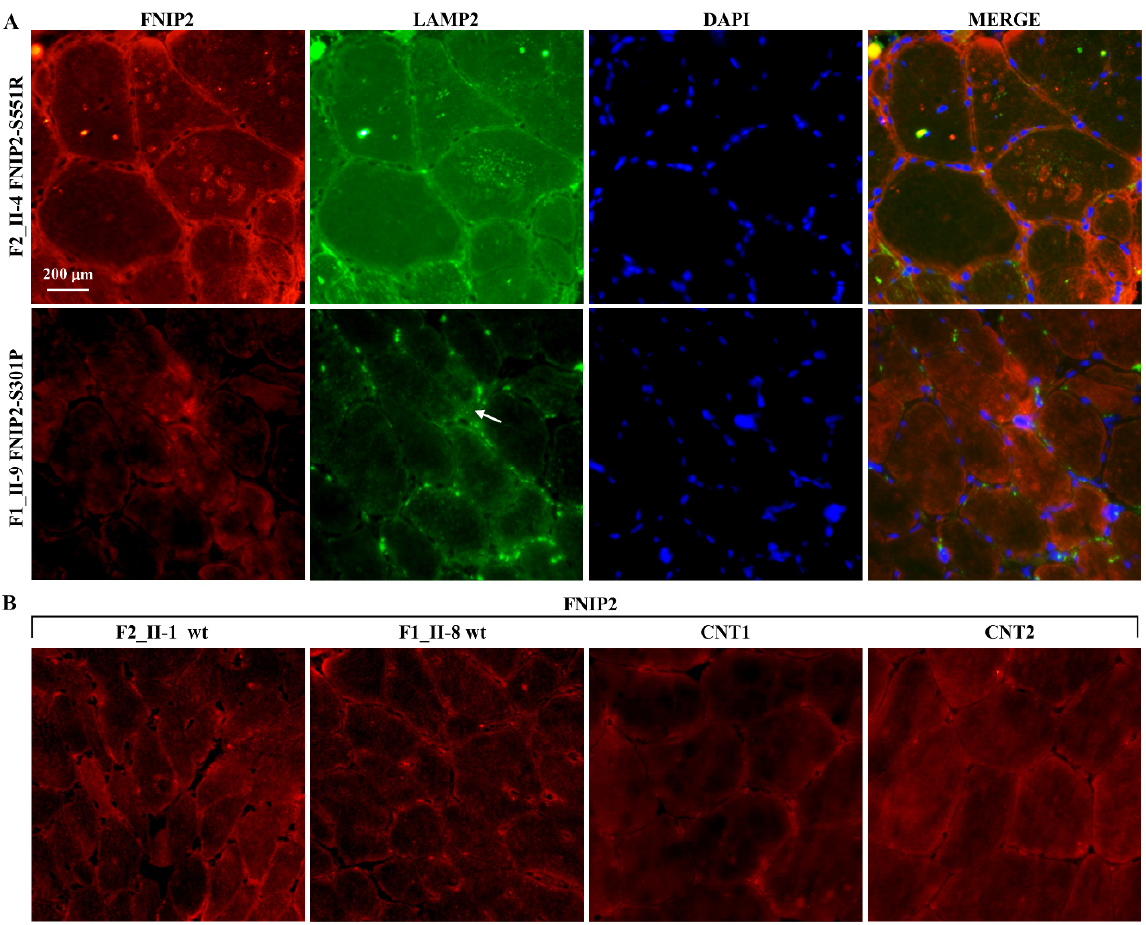
Figure 9. FNIP2 and LAMP2 immuno-localization on skeletal muscle biopsies. ( A ) FNIP2/CY3 expression was continuous and intense at the level of the sarcolemma membranes, and in the sarcoplasmic vacuoles and microvacuoles in FNIP2 [p.S551R] mutated biopsies, while more or less extended irregularly shaped spots of positive signals appeared at the edge in some fibres in (p.S301P) mutated biopsies. The LAMP2/FITC reaction was quite superimposable to that of FNIP2 in these biopsies. ( B ) A faint and diffuse FNIP2/CY3 positive reaction was observed at the sarcolemma and sarcoplasm of muscle fibres in both the wild type individuals and external controls (CNT1, CNT2). Nuclei were counterstained with DAPI (blue). Scale bar: 200 μ m.